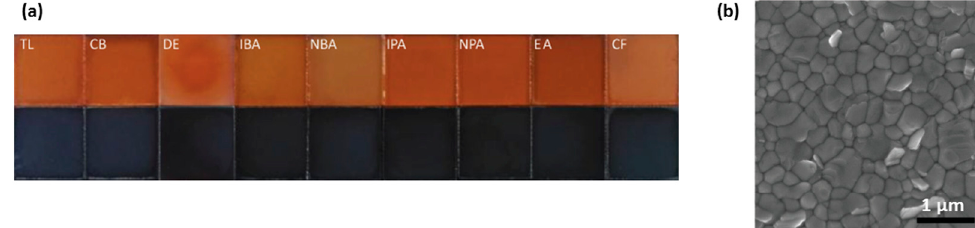
Figure 10. ( a ) Photographs of perovskite films fabricated using different anti-solvents before (the top brown one) and after annealing (the bottom black one) ( b ) Top view SEM images of the EA-processed perovskite films after annealing. Reproduced from Ref. [66] with permission from Wiley-VCH.